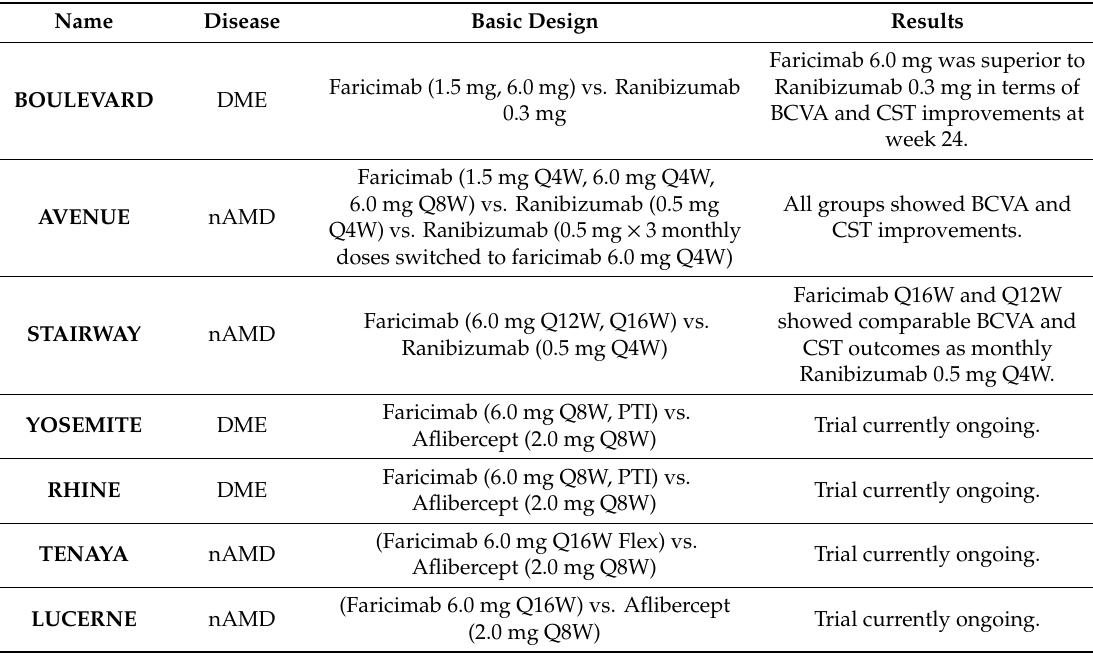
Table 1. A summary of recent clinical trials involving